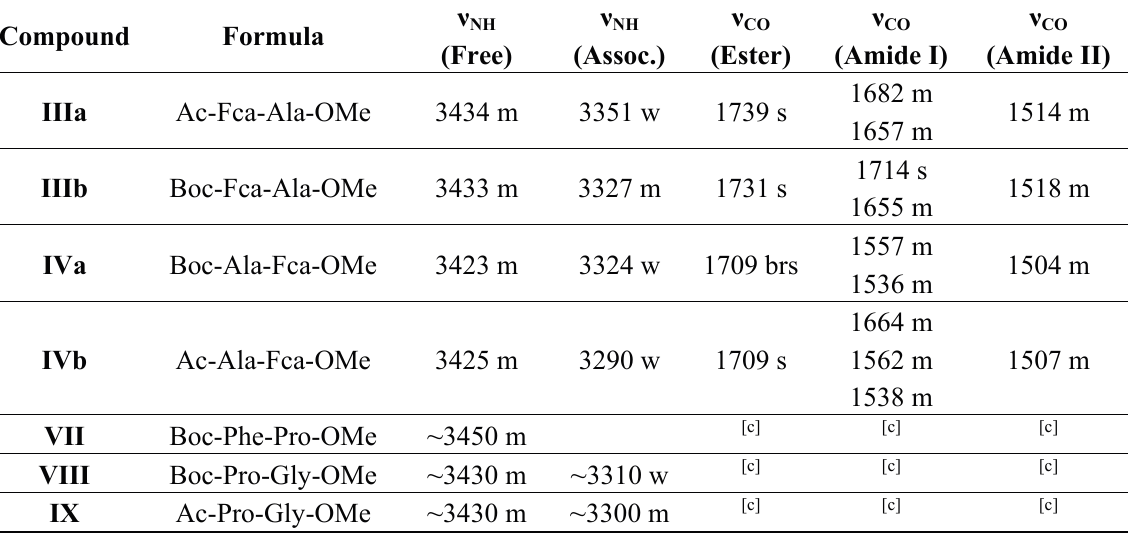
Table 2. IR spectroscopic data (cm − 1 ) of model compounds III [a] , IV [a] , VII - IX [b] .